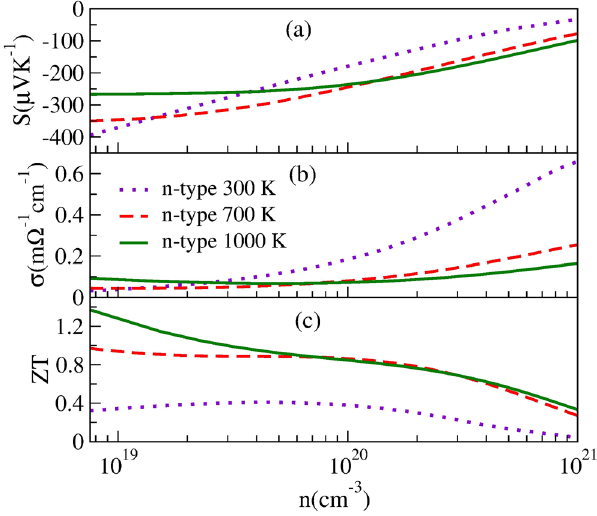
Figure 8. Calculated electrical transport coefficients of Hf 0.5 Zr 0.5 NiSn 0.98 Sb 0.02 as a function of carrier concentration at 300 K, 700 K, and 1000 K.